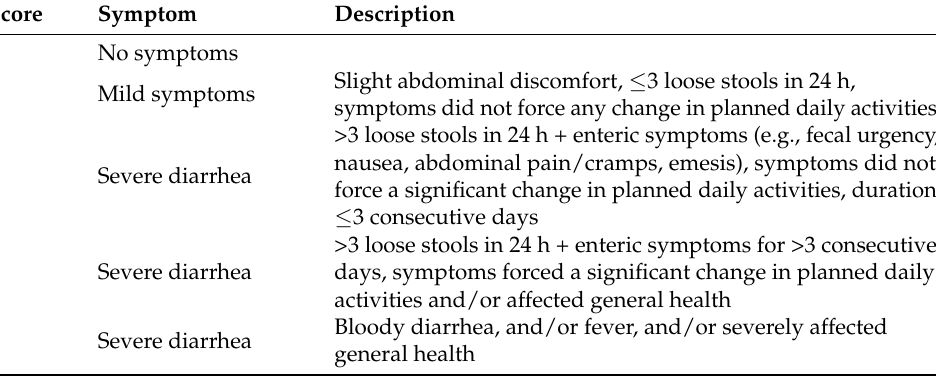
Table 2. Scoring of intestinal symptoms based on questionnaires filled out by